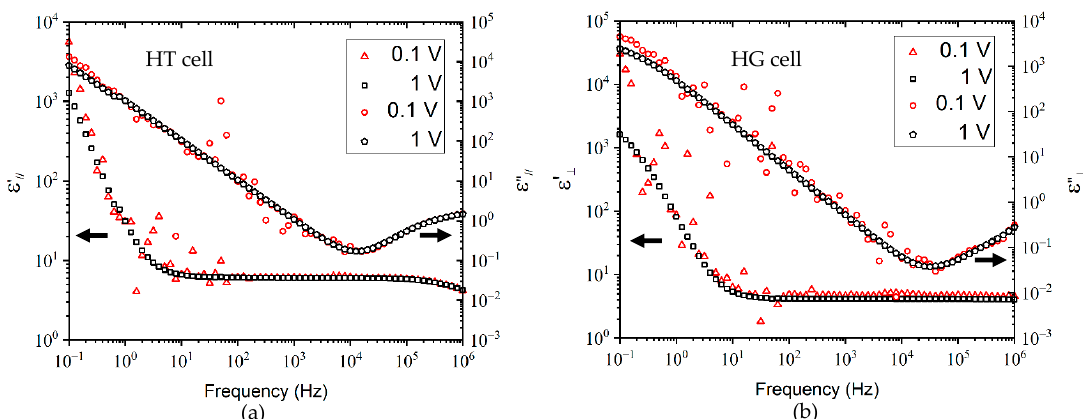
Figure 1. Dielectric spectra of a non-purified LC mixture at room temperature (20 °C), using 20 µm cells in ( a ) homeotropic and ( b ) homogeneous alignment, for two amplitudes of the oscillating voltage: 0.1 and 1 V.